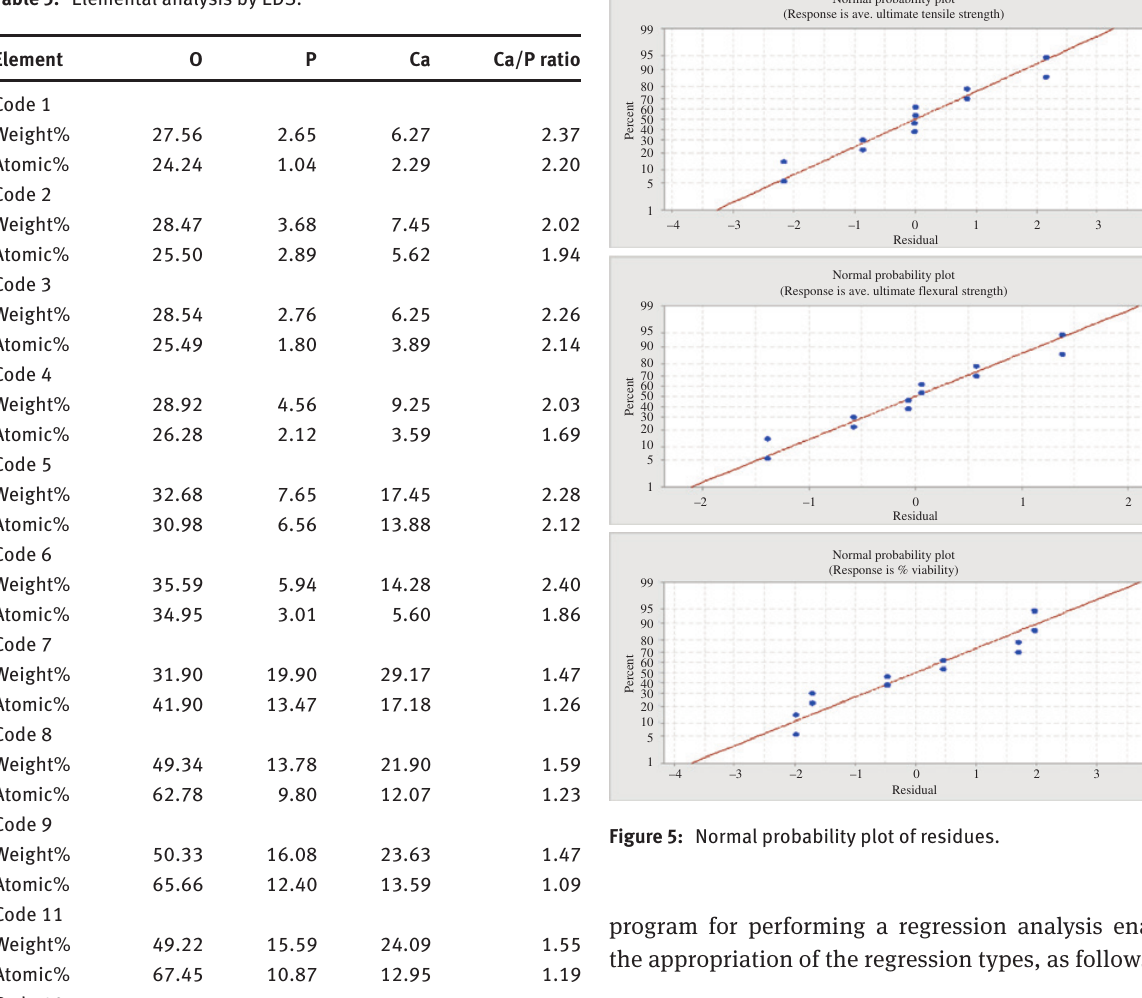
Table 5: Elemental analysis by EDS.